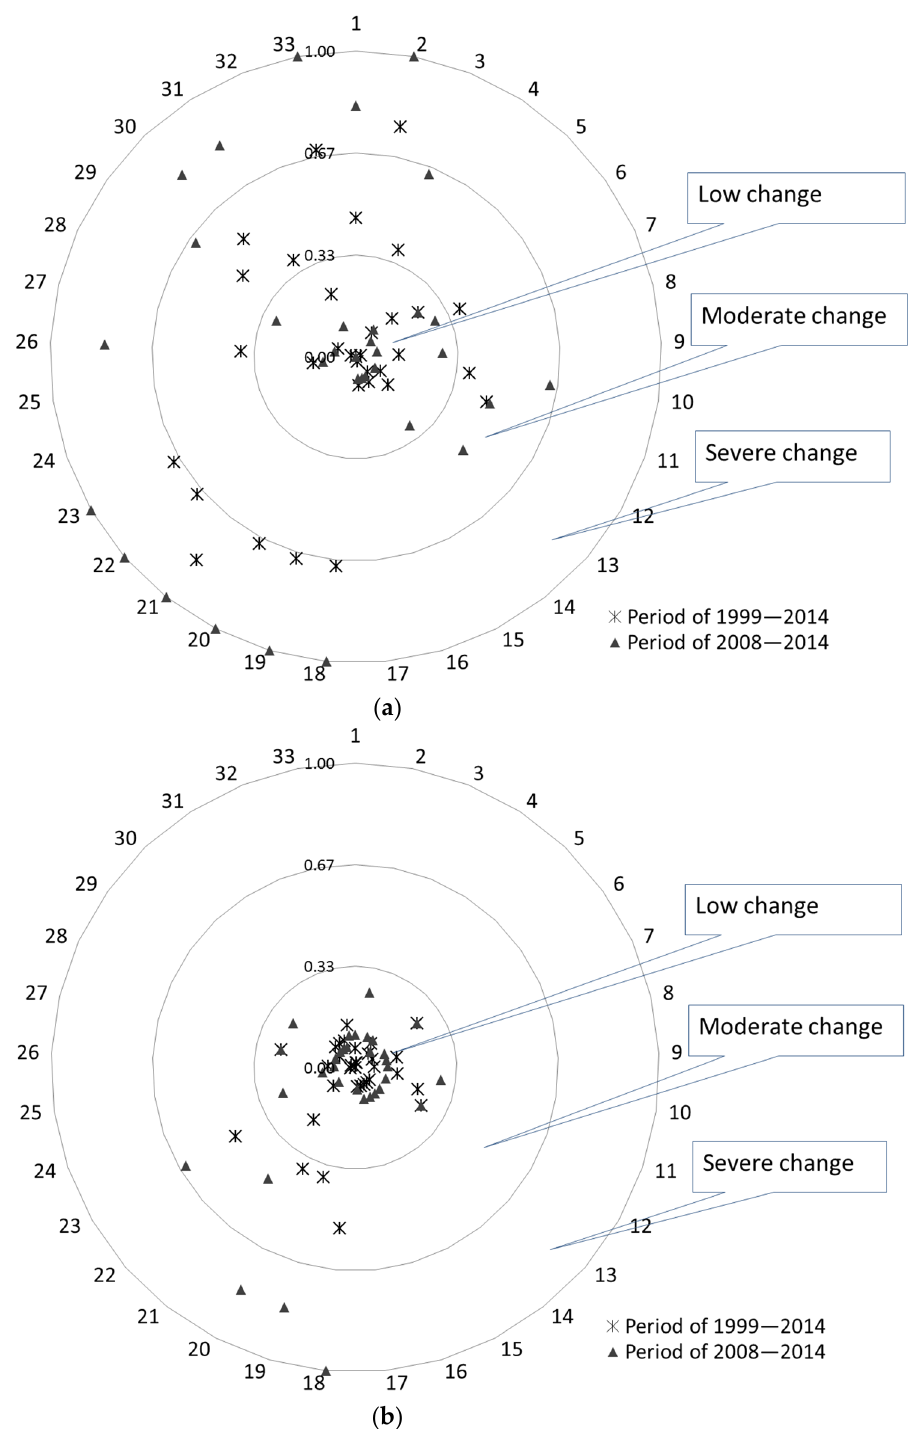
Figure 4. Concentric circle diagram for IHA factors during 1999–2014. ( a ) Yichang station; ( b ) Datong station.